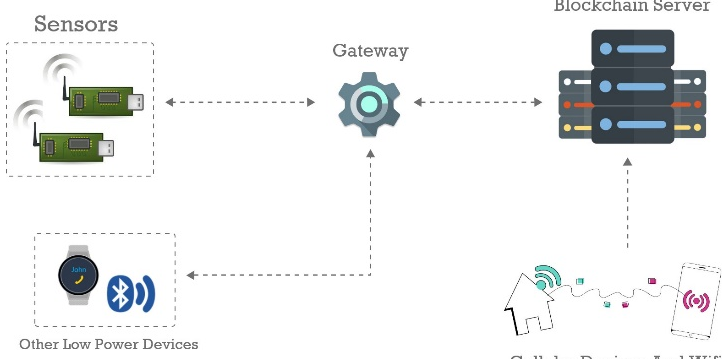
Figure 9. Blockchain in Internet of Things